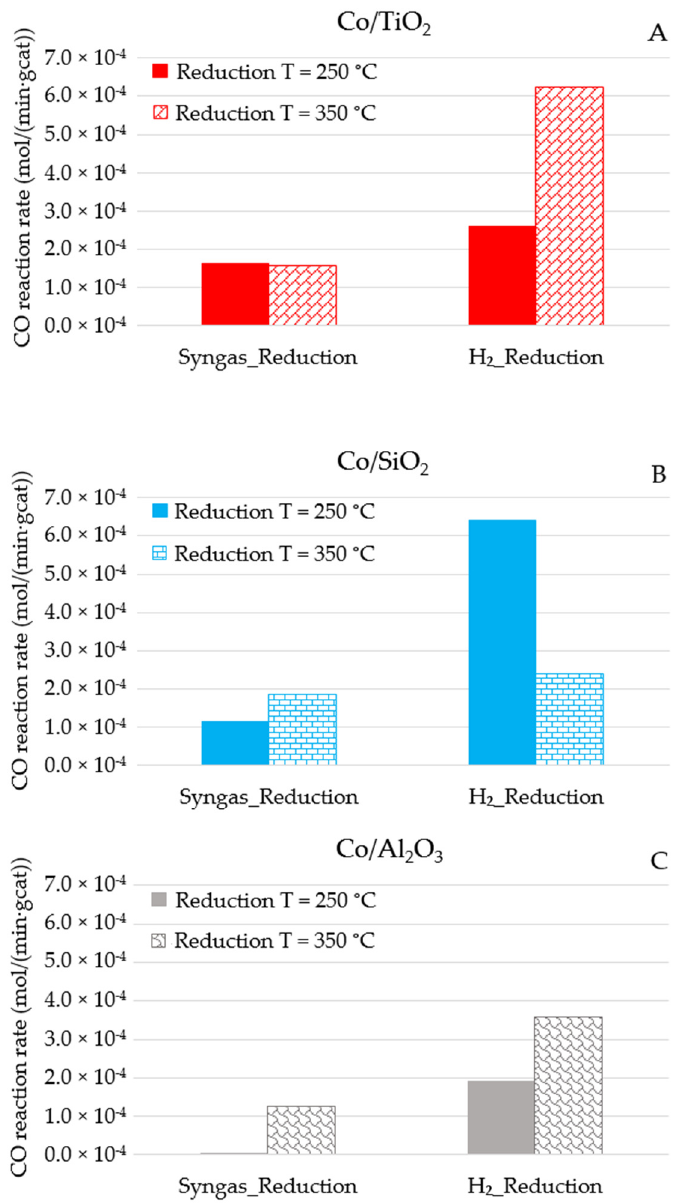
Figure 4. CO reaction rate as a function of reducing agent and temperature: ( A ) for Co/TiO 2 , ( B ) for Co/SiO 2 , and ( C ) for Co/Al 2 O 3 . Reaction conditions: 20 bar, 60 mL/min, and 210 °C.